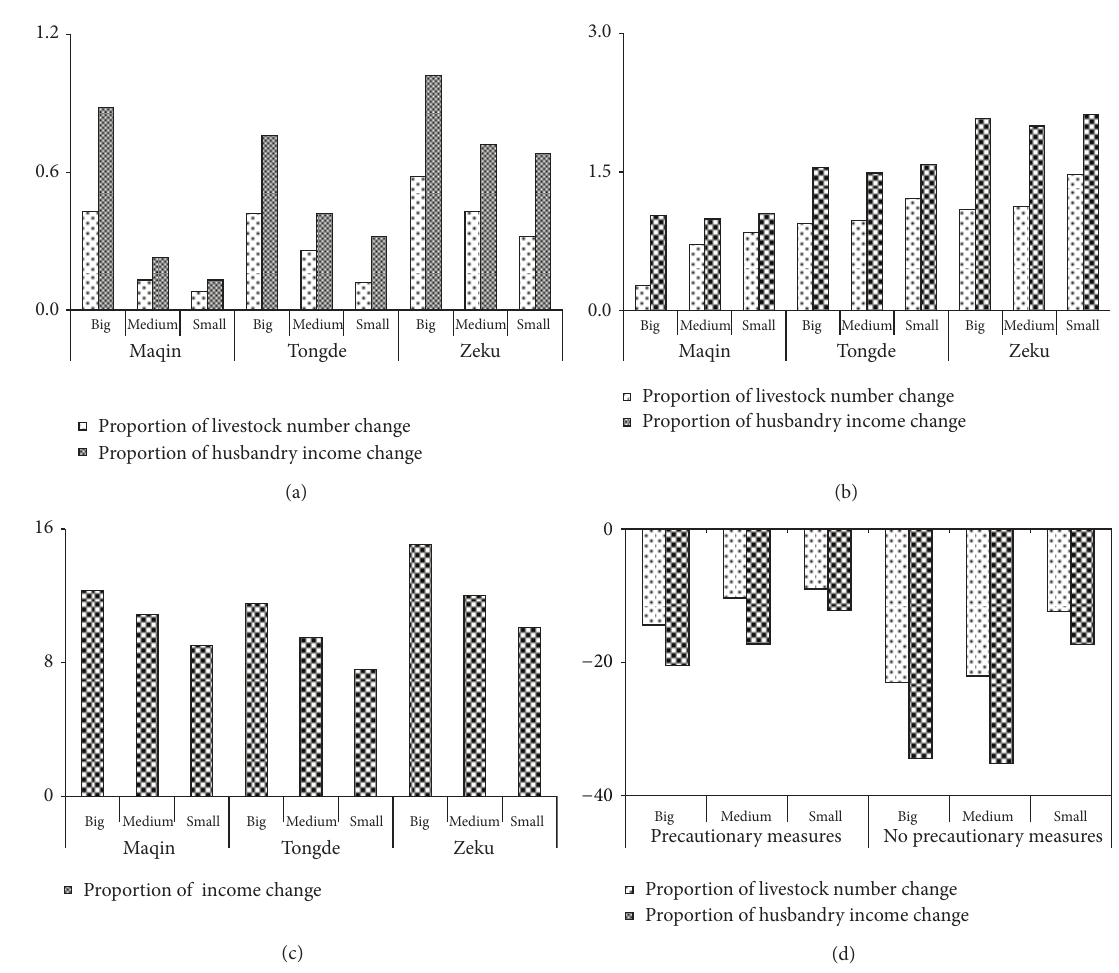
Figure 1: Mathematical analysis of herdsmen’s adaptation to climate change including the technical measures (a), engineering measures (b), government subsidies (c), and extreme weather adaptation (d), from three-level pasture scales, such as large (0.67km 2 –4.33 km 2 ), medium (0.13km 2 –0.67 km 2 ), and small (0.01km 2 –0.13 km 2